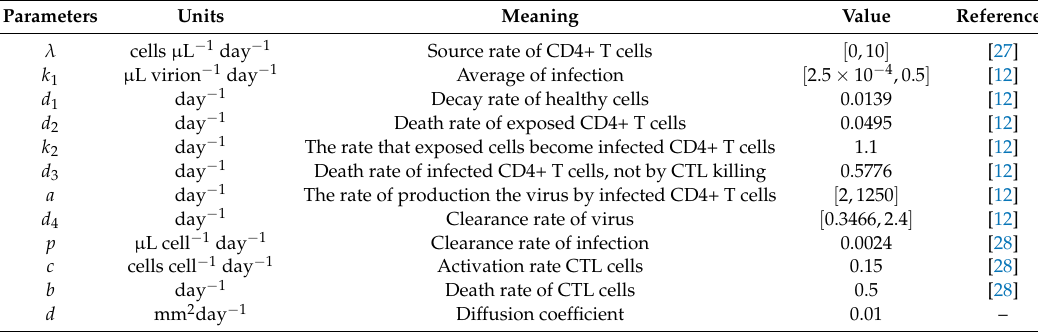
Table A1. The values, units and meaning of all used